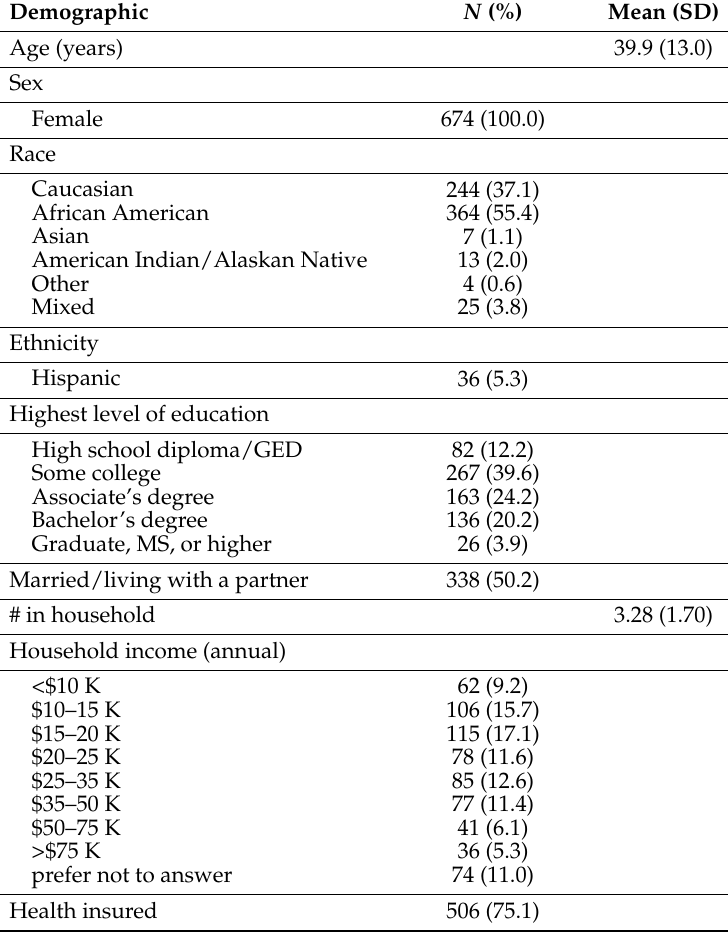
Table 1. Participant demographics.